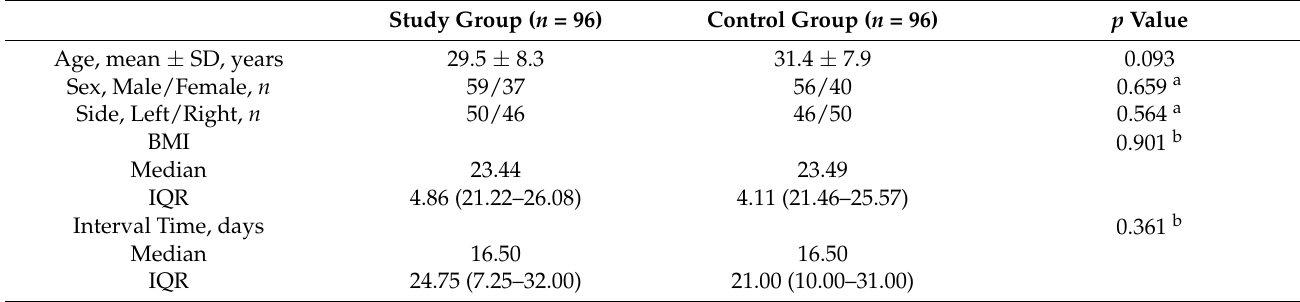
Table 1. Demographic data of the included subjects.